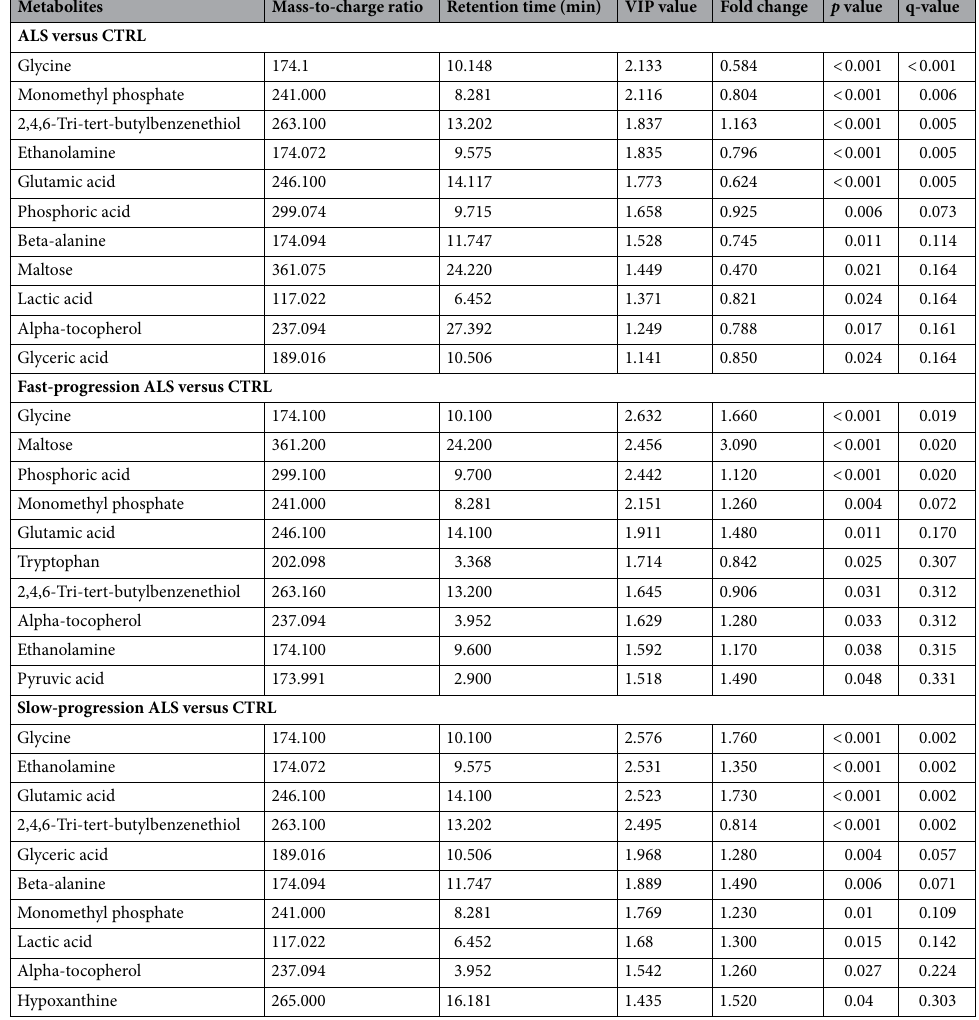
Table 2. Differential metabolites in ALS patients versus healthy